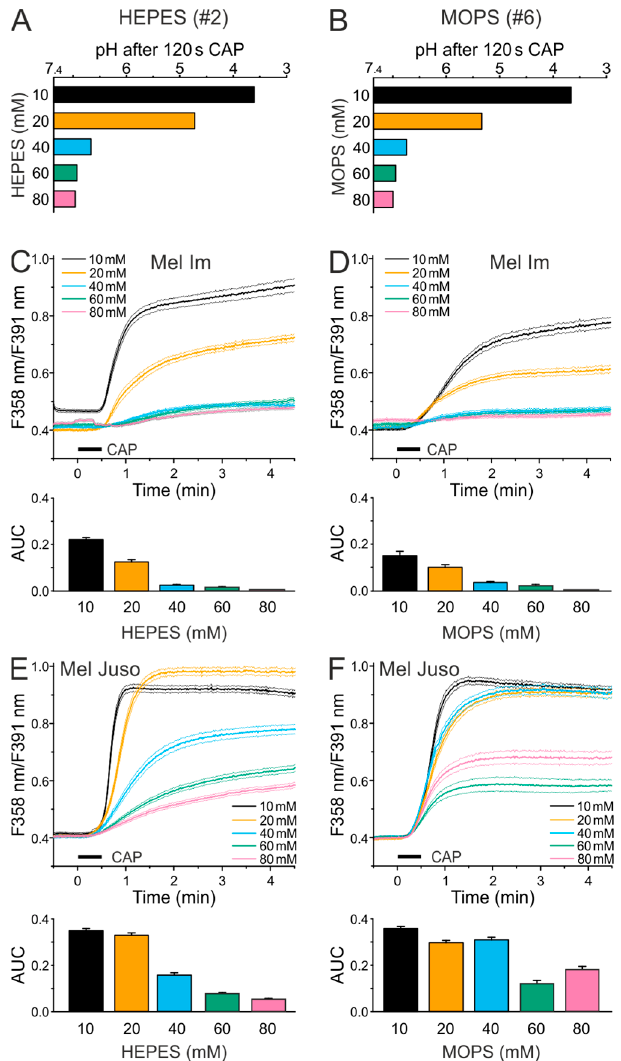
Figure 2. CAP-induced Ca 2+ influx decreases in Mel Im and Mel Juso cells with increasing buffer concentration. Experiments in HEPES-buffered solutions are reported in the left panels ( A,C,E ), the respective experiments in MOPS-buffered solutions in the right panels ( B , D , F ). ( A , B ) Measurement of the pH of different HEPES- ( A ) and MOPS- ( B ) buffered solutions (7 × 20 µL) after 120 s CAP treatment, using a 1.5 mL reaction vessel. Data are shown as mean. ( C – F ) Cytoplasmic Ca 2+ levels stimulated by 30 s CAP exposure of Mel Im ( n = 220–603) and Mel Juso ( n = 223–377) cells in different HEPES- ( C , E ) and MOPS- ( D , F ) buffered solutions.